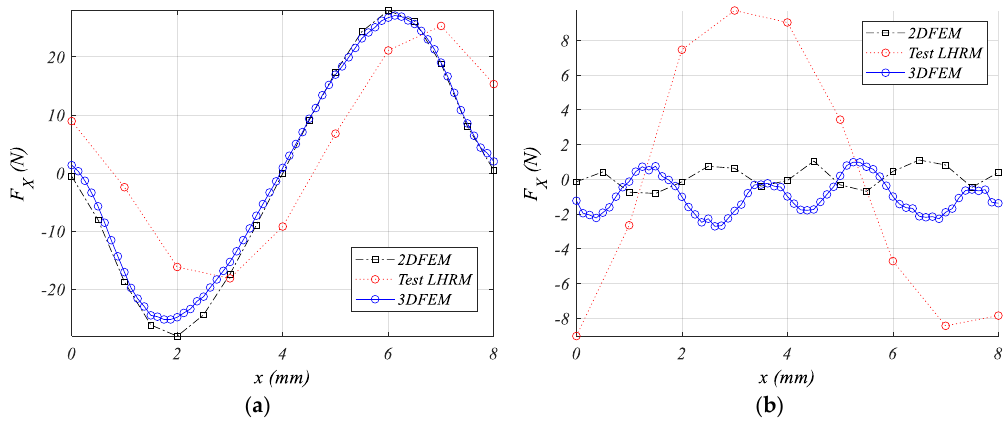
Figure 15. 2DFEM vs. experimental detent force comparison results. ( a ) s = 0 mm. ( b ) s = 4 mm.